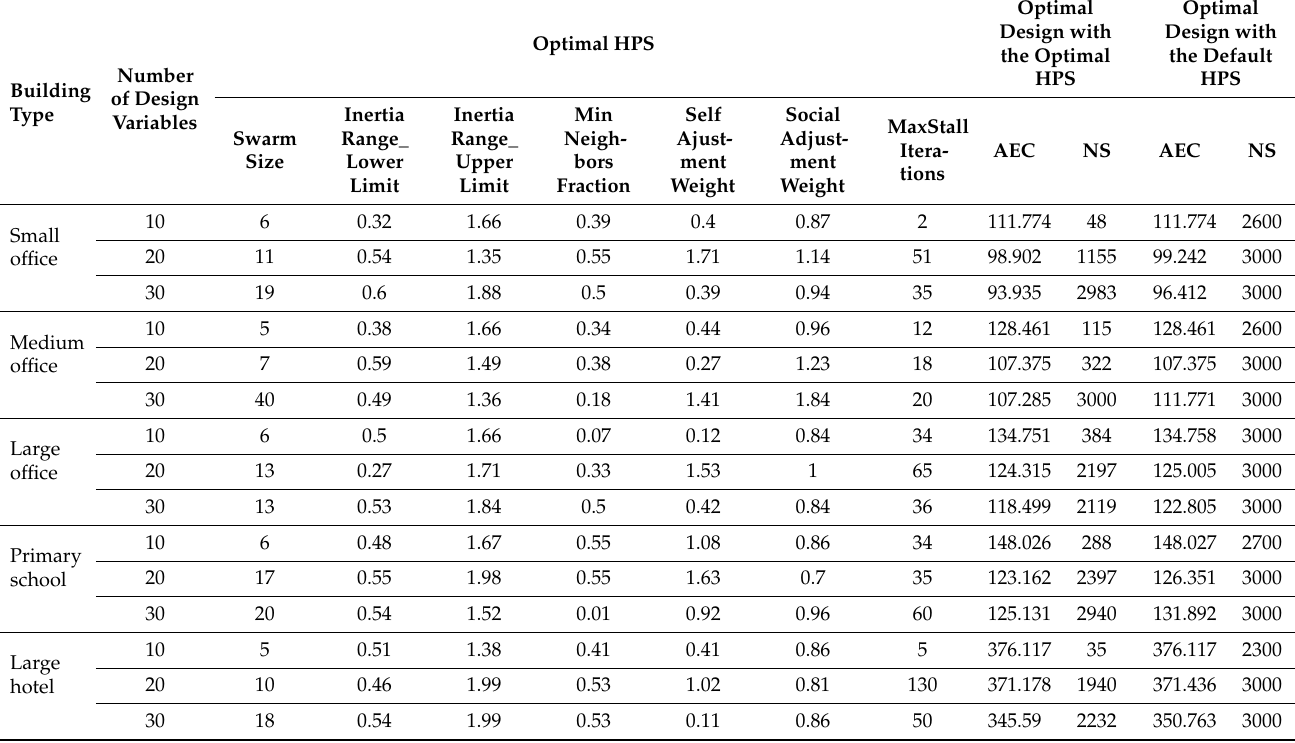
Table 6. Optimal HPSs for the